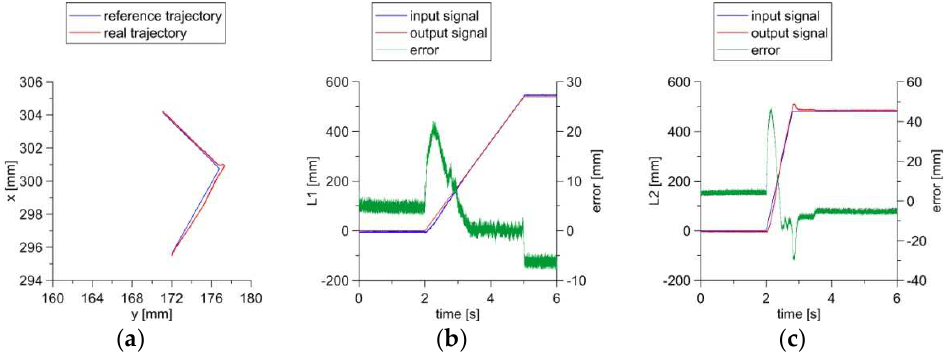
Figure 7. The positioning of the manipulator end effector along a section of the square trajectory: ( a ) end-effector trajectory, ( b ) displacement of actuator A1, ( c ) displacement of actuator A2.